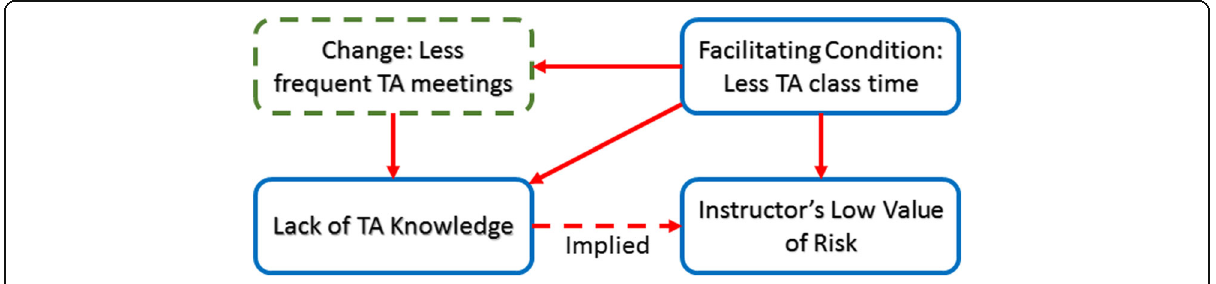
Fig. 4 Revealed Causal Map for Instructor D, changing TA